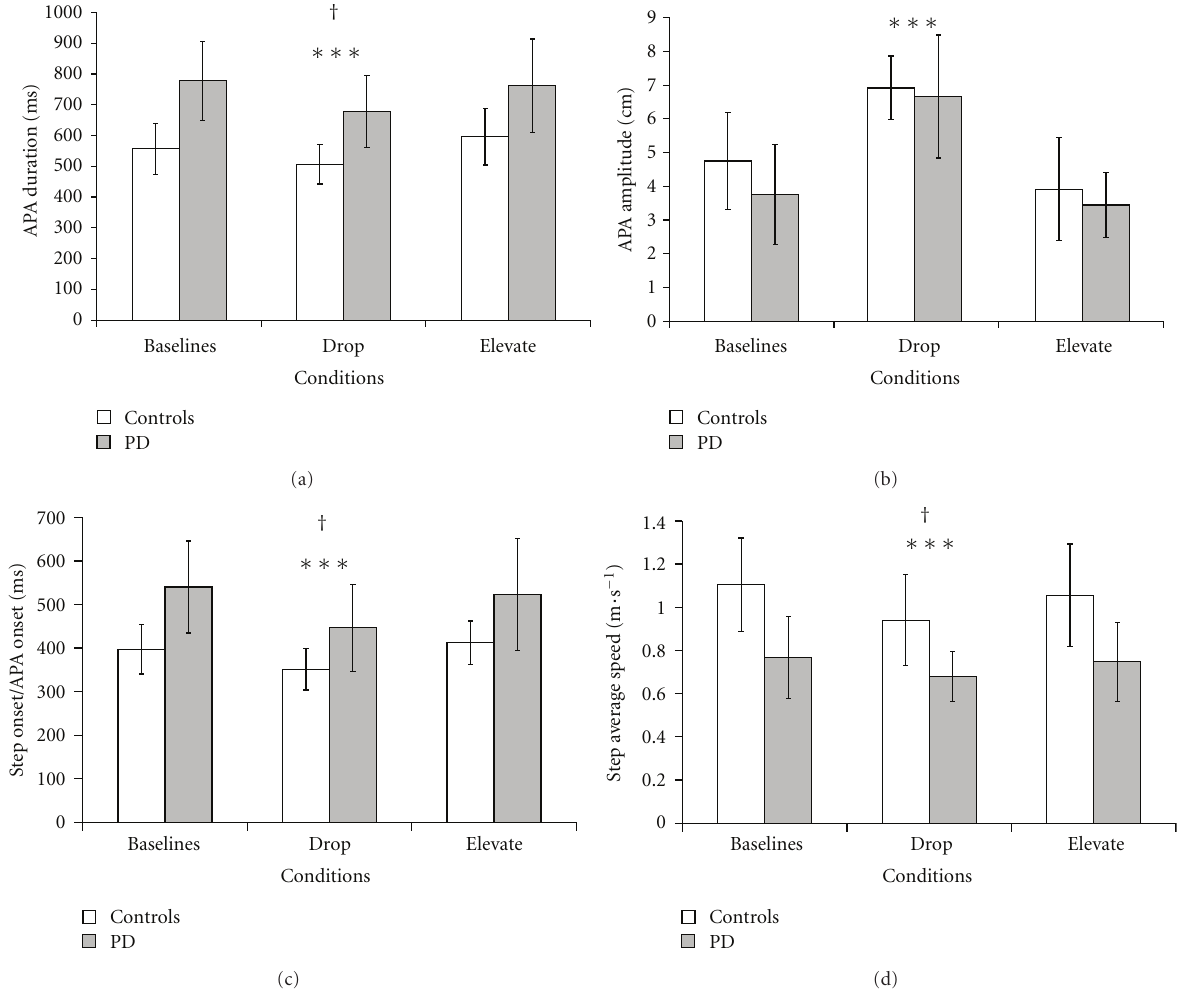
Figure 3: The group mean values ( ± 1 SD) for patients with Parkinson’s disease (PD) on medication (gray bars) and healthy control subjects (white bars) during rapid self-paced step initiation under the di ff erent experimental conditions are presented for (a) APA duration, (b) APA amplitude, (c) step onset relative to the APA onset, and (d) first-step speed. Data from [53]. † Significant di ff erences between groups. ∗∗∗ Significant di ff erence between the postural assistance condition (DROP) and the other